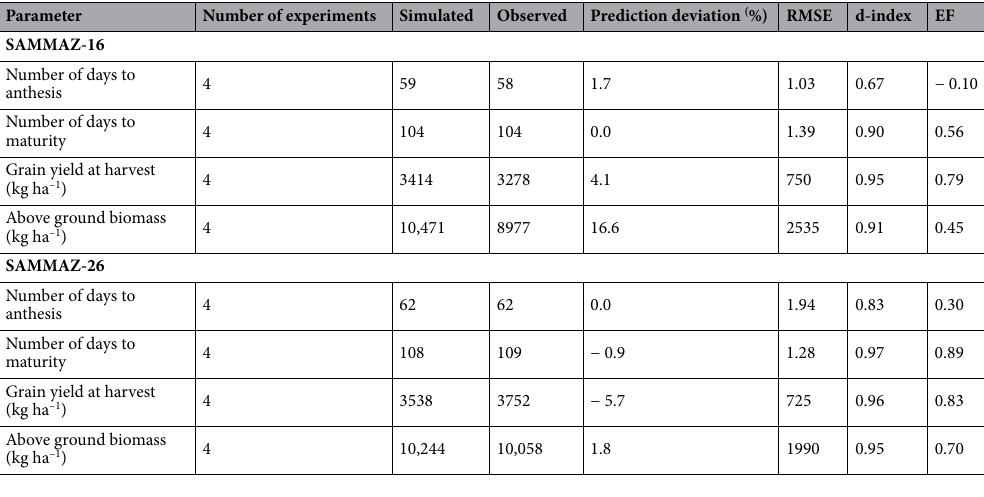
Table 3. Comparisons of simulated and observed mean values on days to anthesis, days to maturity, grain yield, and above ground biomass for model evaluation with their respective statistical indices for the calibrated maize varieties.